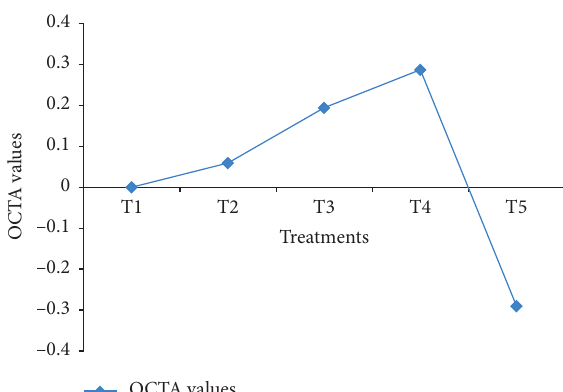
Figure 4: OCTA trend for the number of leaves